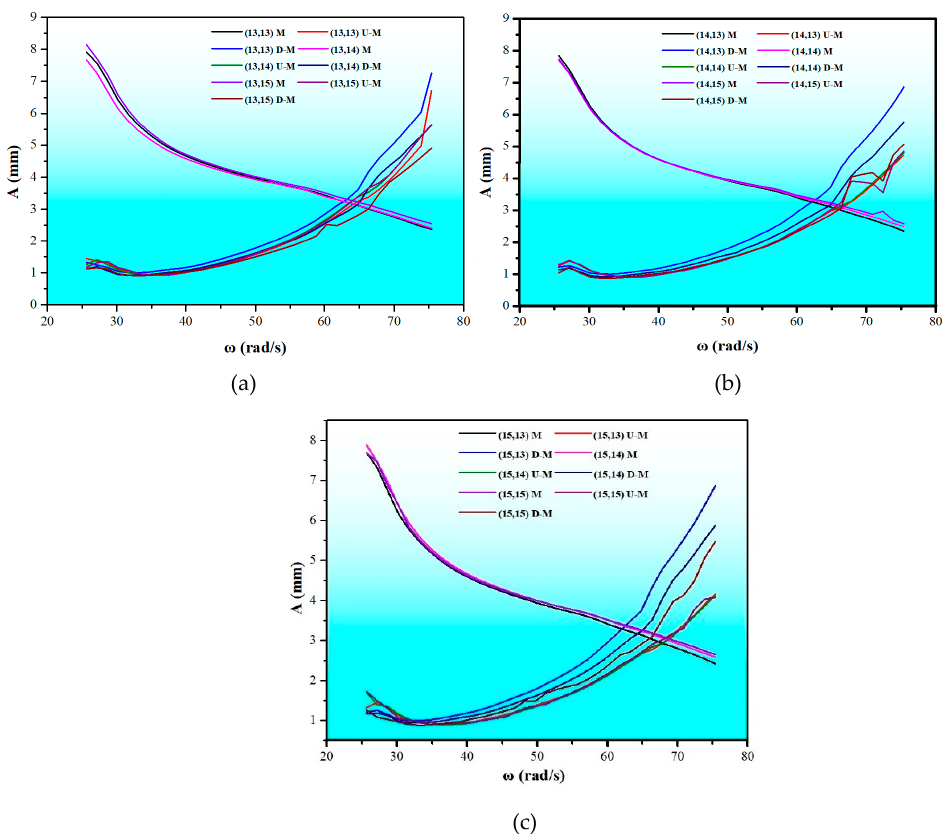
Figure 10. Influence of the stiffness variation on the amplitude–frequency characteristic curves: ( a ) 13, X; ( b ) 14, X and ( c ) 15, X.